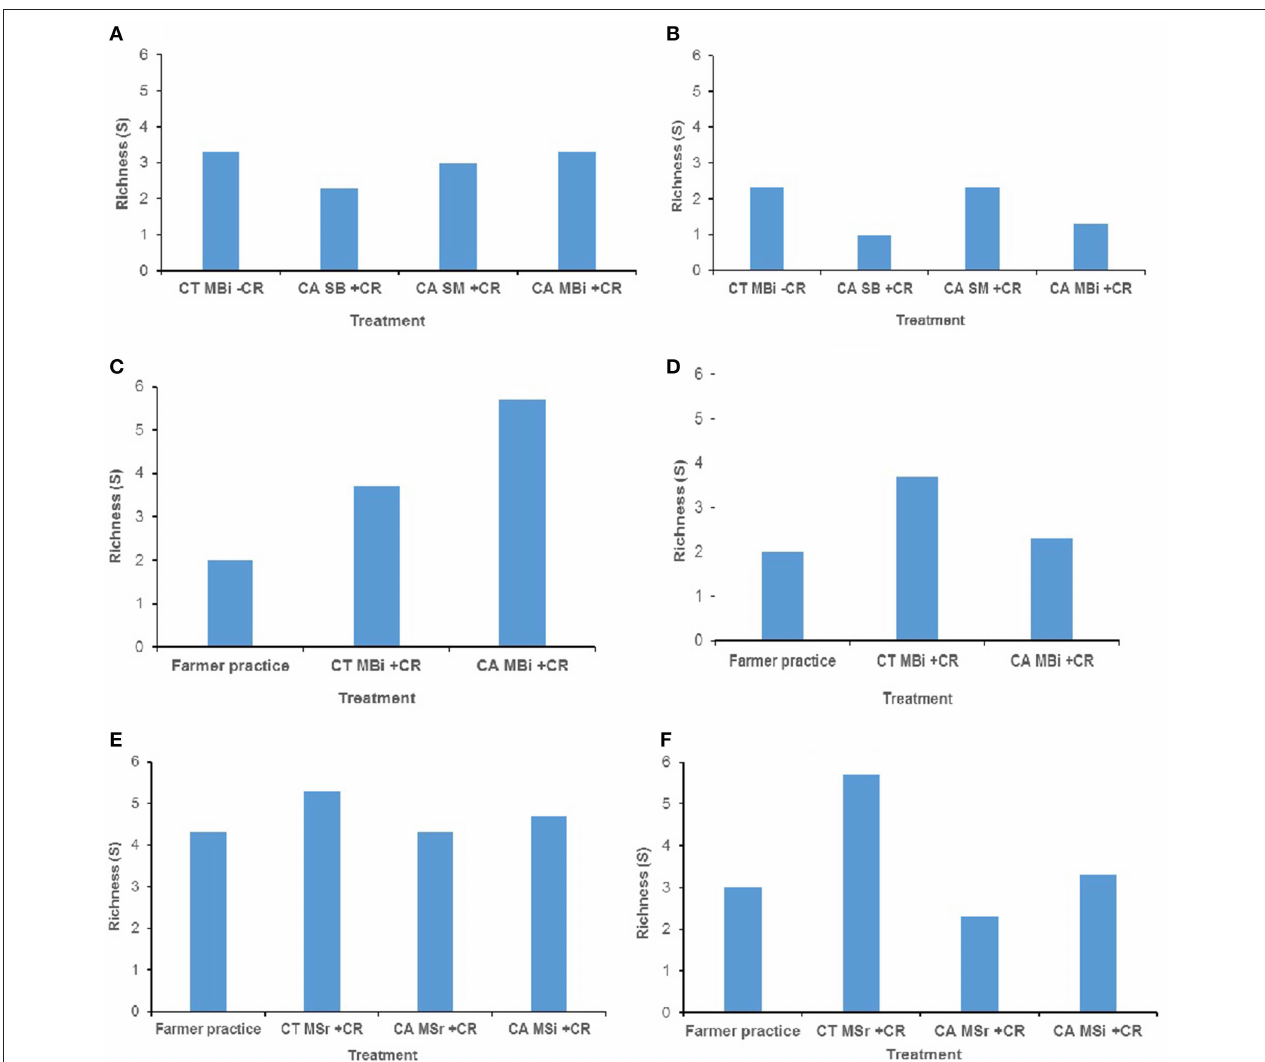
FIGURE 2 | Soil mesofauna diversity (richness) across trials of Embu, Kakamega, and Nyabeda. MT, Medium-term; LT, Long-term; CT, Conventional till; CA, Conservation agriculture (Zero till); SM, Sole maize; SB, Sole beans; MBi, Maize bean intercrop; MSi, Maize-soybean intercrop; MSr, Maize-soybean rotation; CR, Crop residue. (A) Embu MT (0-15 cm, p = 0.864); (B) Embu MT (15-30 cm, p = 0.515); (C) Kakamega MT (0-15 cm, p = 0.058); (D) Kakamega MT (15-30 cm, p = 0.502); (E) Nyabeda LT (0-15 cm, p = 0.405); (F) Nyabeda LT (15-30 cm, p =